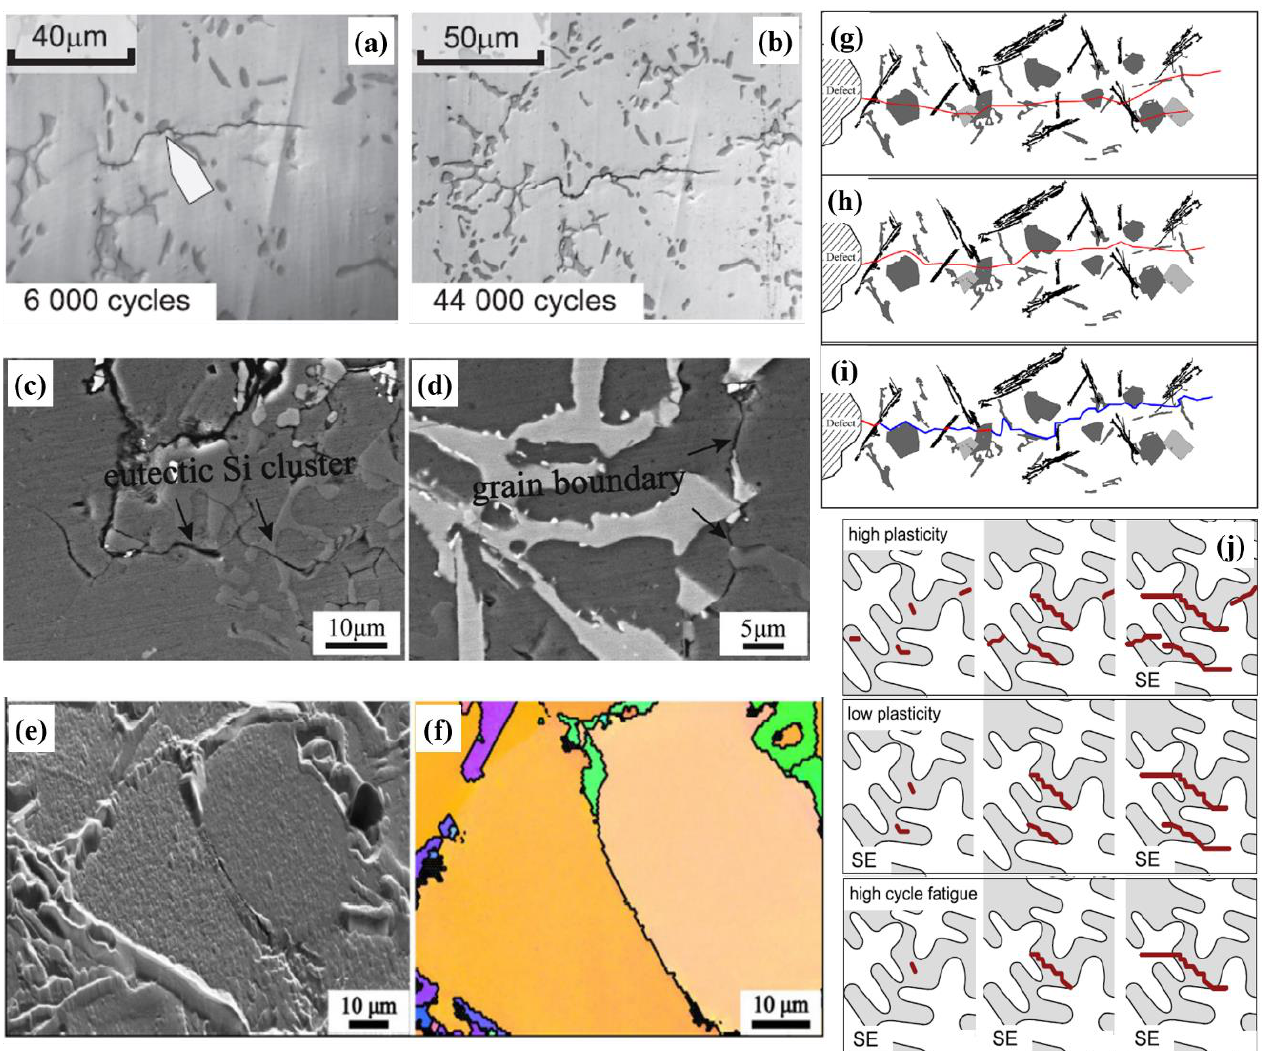
Figure 17. ( a , b ) Microcrack nucleation in Al-6%Si-4%Cu alloys under rotating–bending HCF at different stages (arrows indicate the initial crack nucleation site, i.e., debonding silicon particle) [262]. ( c ) Cross-sectional area beneath the fatigue initiation site for Al-Si piston alloys showing fractured eutectic Si cluster and ( d ) cracking of grain boundary among intermetallics [58]. ( e , f ) SEM and EBSD images showing cracked grain boundary in HCFed Al-10%Si-Cu-Mg-Ni alloy at 425 °C [265]. ( g – i ) Schematic mechanisms of fatigue crack initiation and propagation at (g) RT, (h) 350 °C, and ( i ) 425 °C (red line: transgranular crack; blue line: intergranular crack) [58]. ( j ) A schematic for high- and low-plasticity LCF and HCF in different fatigue states (SE: significant event, with the main stress axis being vertical) [262]. Reproduced with permission from Elsevier and John Wiley and Sons.